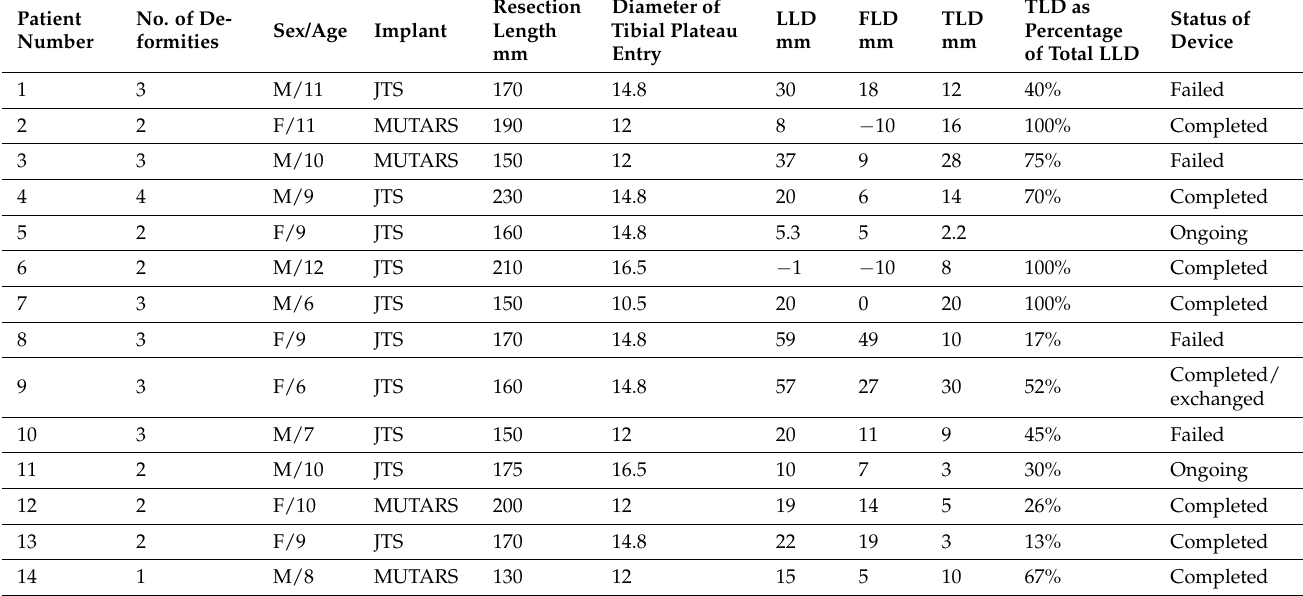
Figure 2. A scatter plot depicting the presence of an association between deformities and age but no significant association between deformities and tibial plateau entry diameter. Table 1. Patients’ leg length discrepancy data and surgical details [15,16].